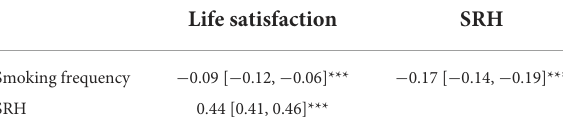
TABLE 2 Correlations between smoking frequency, SRH, and life